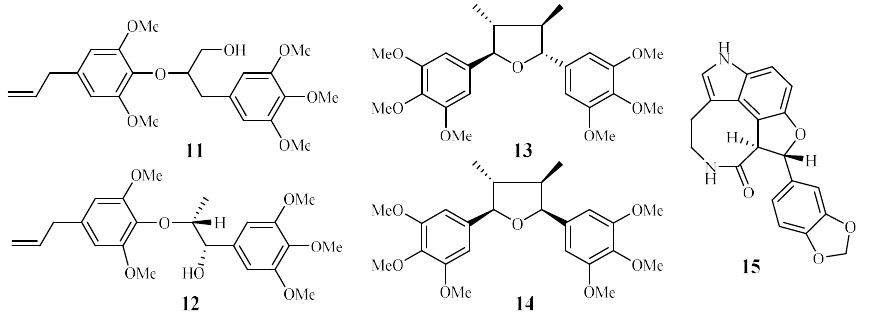
Figure 4. Compounds from an Araceae plant.